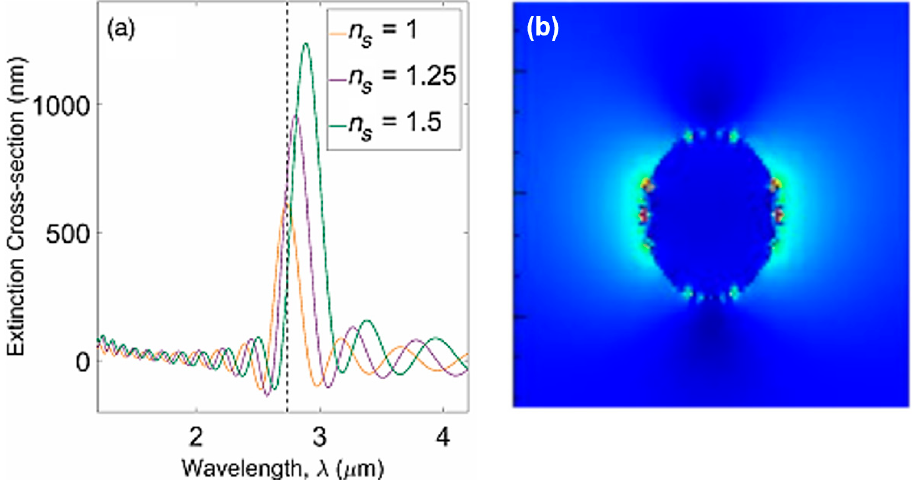
Figure 8. ( a ) Silicon-doped NW sensor with plasmonic resonance at 3 µ m, having surrounded refractive index, n = 1, 1.25, and 1.5 in the surrounding. ( b ) Mode profile at 3 µ m at the cross-section of the nanowire. The near field intensity (color) in ( b ) shows the maximum field in the center of the nanowire being shown at the cross-section. Reprinted with permission from Ref. [103].